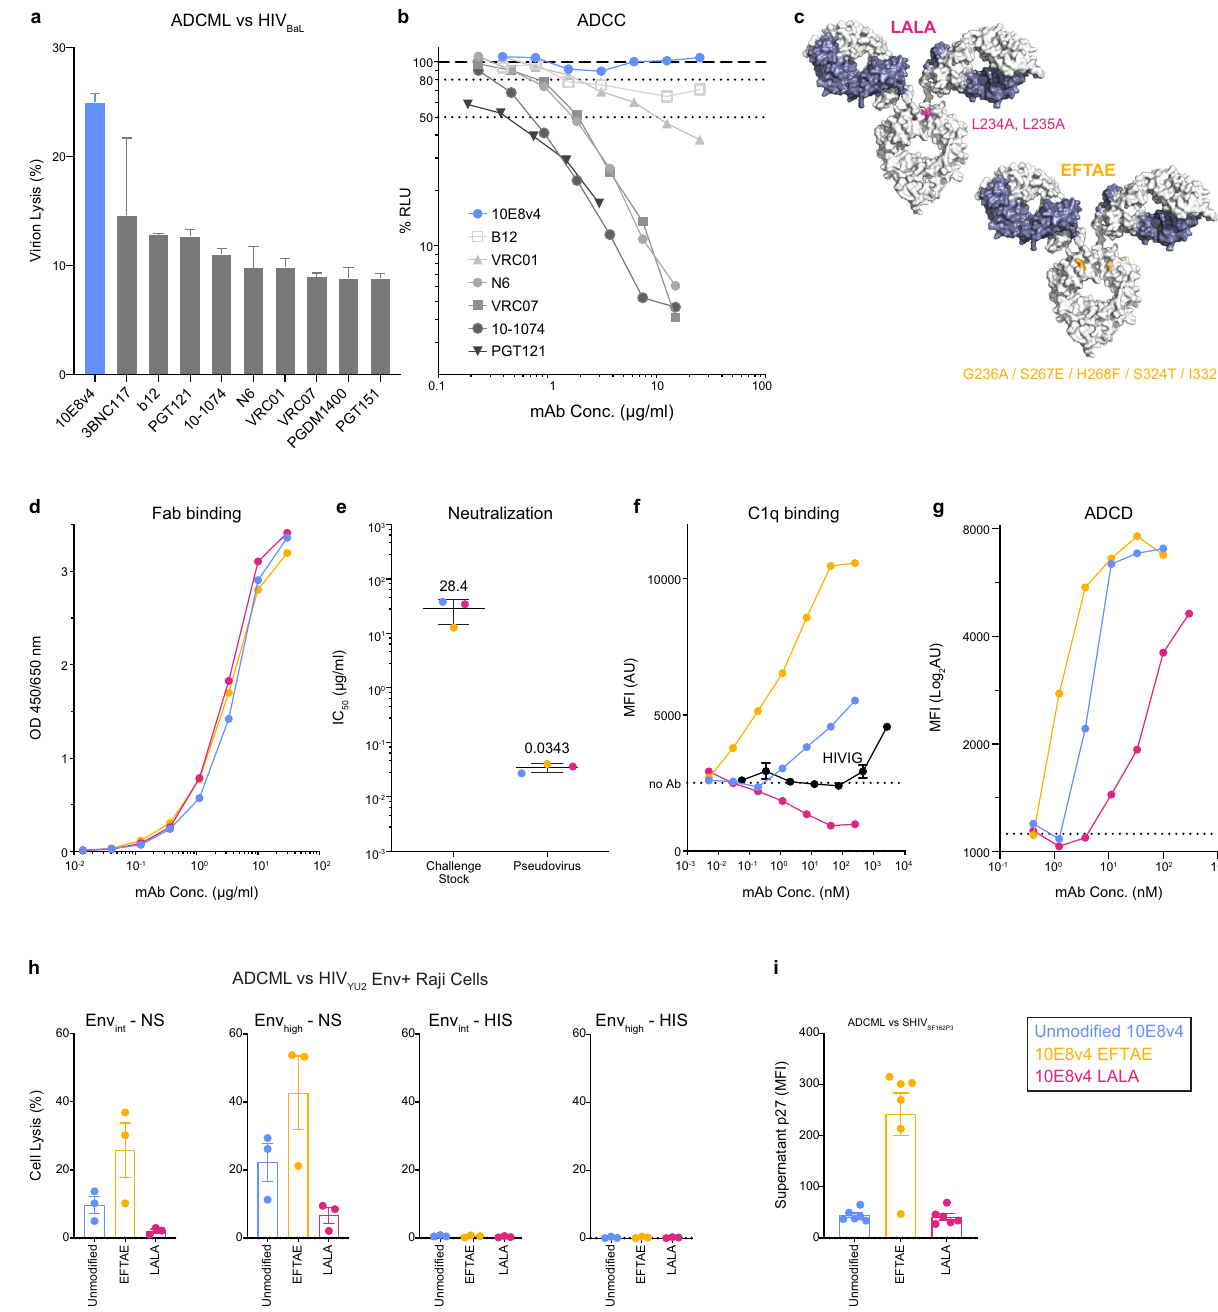
Fig. 1 Fc variant EFTAE enhances complement-mediated functions of bNAb 10E8v4. a C ’ -mediated lysis of HIV BaL virions incubated with a panel of bNAbs in normal serum. Data shown are mean ± SD of two replicates. Lysis was measured by fl ow cytometric quanti fi cation of supernatant p27 with complete lysis determined by incubation with detergent instead of antibody. b Comparative ADCC activity of bNAbs against SHIV SF162P3 -infected target cells expressing luciferase reporter, with greater activity corresponding to a decrease in relative light units (RLU). Data shown are mean only. c Site visualization of Fc point mutations inserted into each IgG1 CH 2 domain. Each mutation is shown on only one arm for clarity. d 10E8v4-unmodi fi ed and Fc- modi fi ed Fab-mediated binding to MPER determined by ELISA and e neutralization of SHIV SF162P3 replication-competent challenge virus (single round infection in TZM-bl cells) and SHIV SF162P3 pseudovirus in the TZM-bl assay. Values shown are mean ± SD among 10E8v4-unmodi fi ed and variants. f C1q binding and g ADCD assessed as C3b deposition to antibody complexed with MPER-coated beads measured by SPR. h Complement-mediated lysis of transduced Raji B cells resulting in either intermediate or high levels of HIV YU2 Env surface expression. Antibody plus cells were incubated with normal (left) or heat-inactivated (right) serum and percent lysed cells determined by fl ow cytometry. Results are reported as the percentage of dead cells above that in wells without antibody, with biological replicates from three independent serum donors. i C ’ -mediated lysis of SHIV SF162P3 virions incubated with 10E8v4 variants in normal serum. Data and analysis are derived from n = 6 animals per group. Analyzed data shown in a , d , f – i are mean ± SD and are representative of at least two independent experiments. Source data are provided in the Source Data fi le associated with this manuscript. The color key is shown and colors are consistent throughout the manuscript. ADCML antibody-dependent complement-mediated lysis, ADCP antibody-dependent cellular phagocytosis, ADCC antibody-dependent cellular cytotoxicity, ADCD antibody-dependent complement